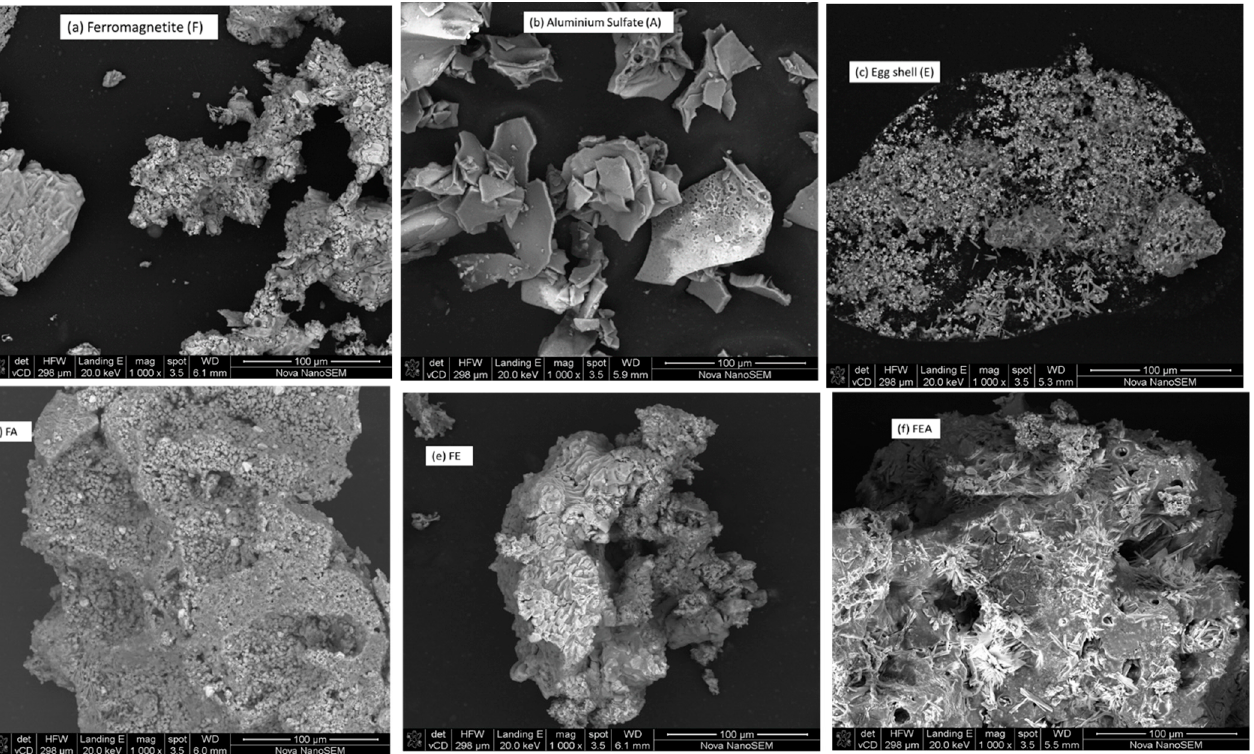
Figure 1. SEM images of: ( a ) Ferromagnetite (F), ( b ) alum (A), ( c ) eggshells (E), ( d ) FA, ( e ) FE, and ( f ) FEA.